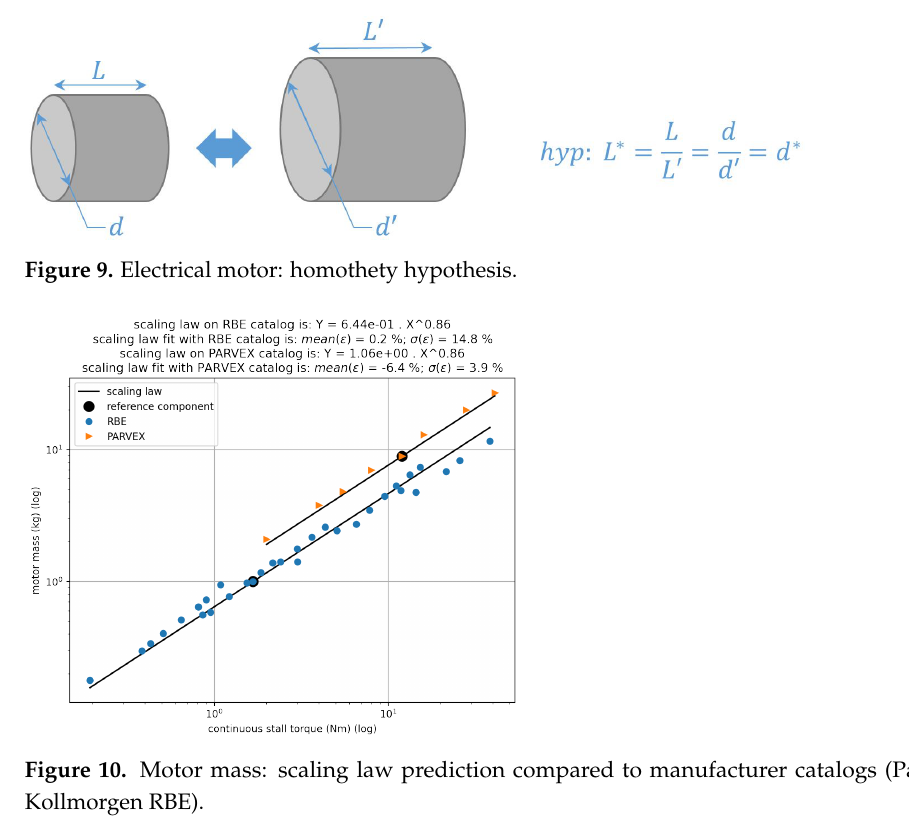
Figure 8. Electrical motor torque formulation.